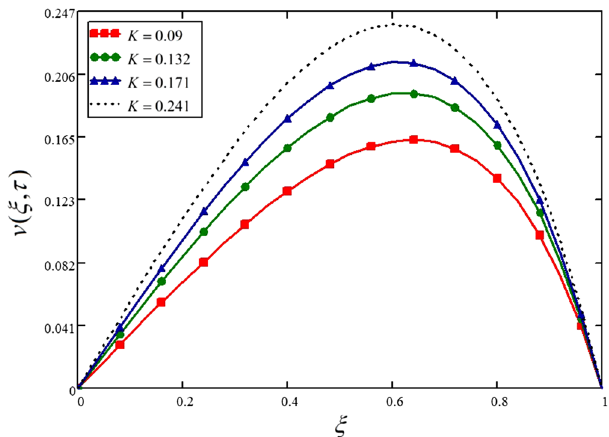
Figure 8. Influence of Darcey number on the nanofluid